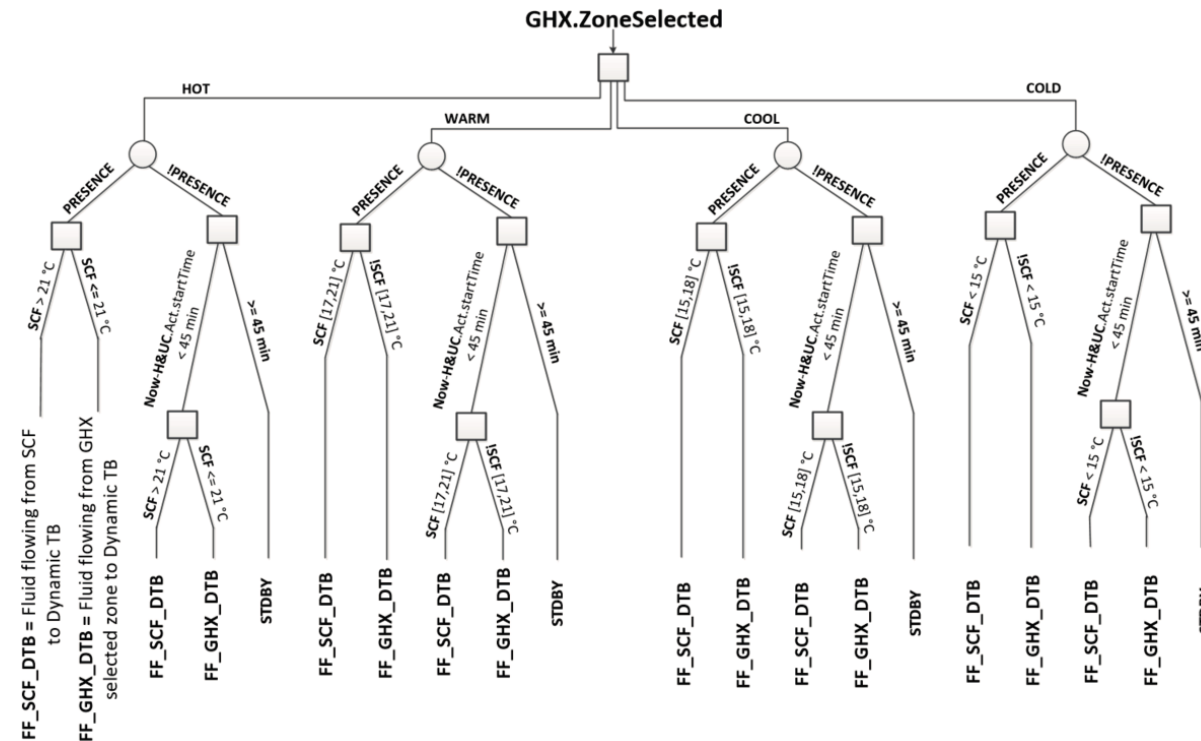
Figure 18. The decision tree designed to activate the dynamic thermal